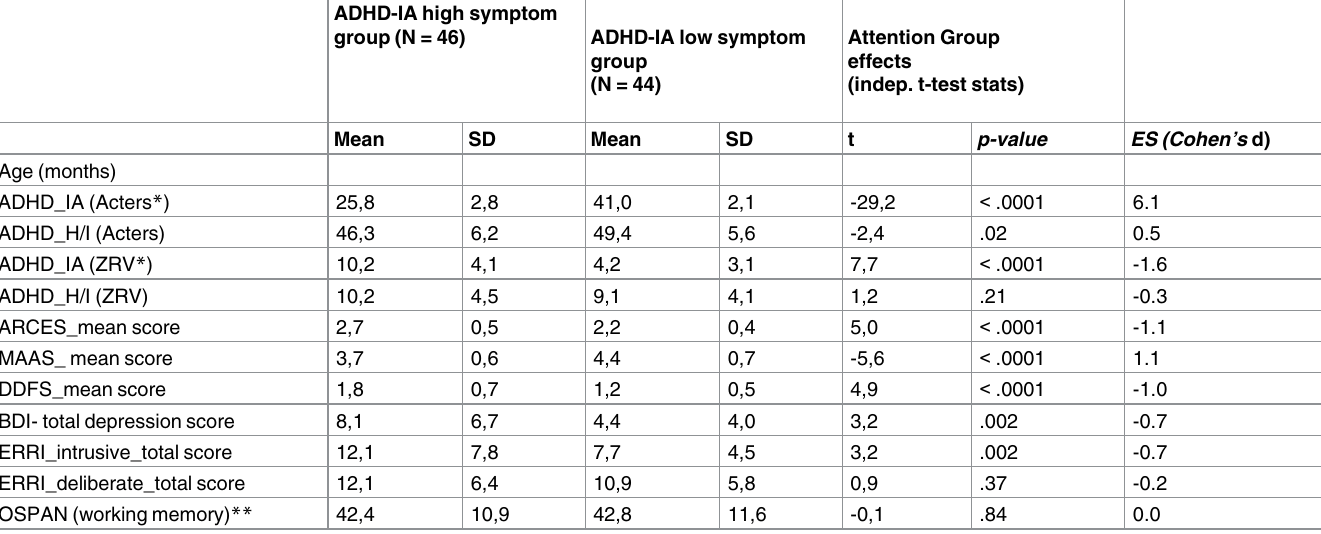
Table 1. Scores and differences between the two attention groups on the different questionnaires filled in before the lab visit and on the OSPAN working memory test performed during the lab session (see text for explanation of abbreviations and content of the questionnaires). IA = Inattention, H/I =